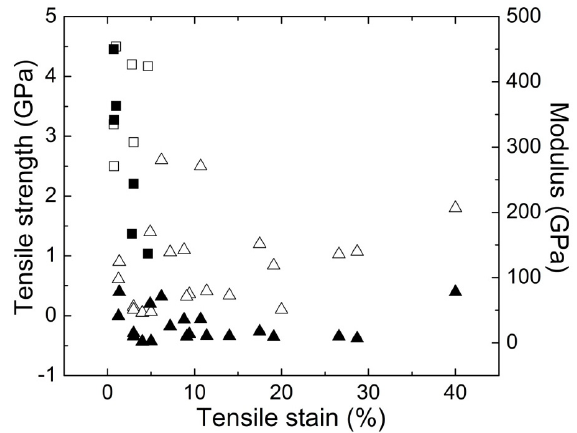
Figure 2. Summary of Young’s modulus, tensile strength, and strain-to-failure properties for various polymer/CNT fibers produced at the research scale which exhibit properties similar to high-performance commercial fibers [35,36,38–47,112–116] (Note: □ / ■ symbols represent tensile strength/modulus properties for high-performance fibers, and ∆ / ▲ symbols represent tensile strength/modulus properties for textile-grade